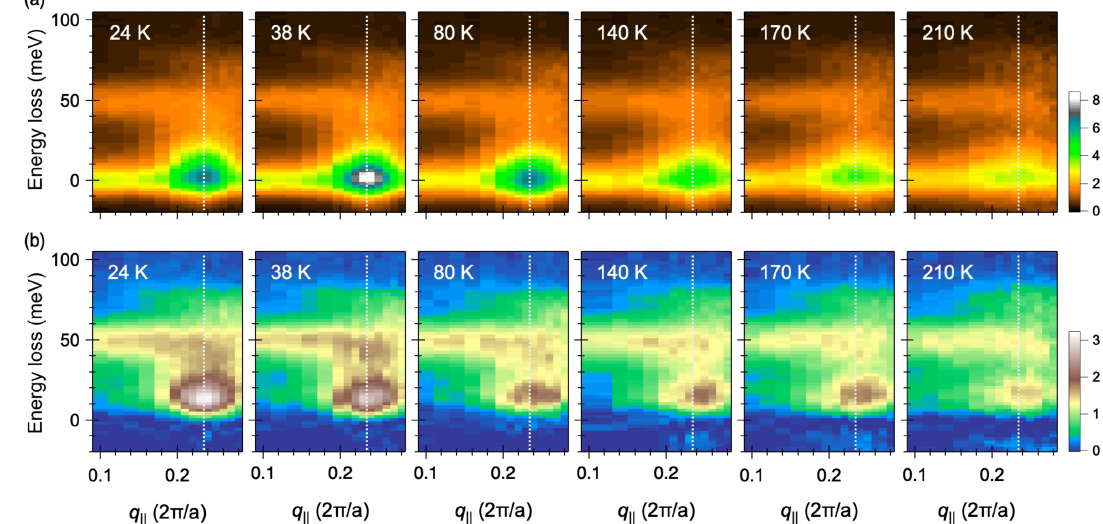
FIG. 2. Temperature-dependent O K -edge RIXS of optimally doped LSCO. (a) RIXS intensity distribution maps in the plane of energy loss vs in-plane momentum transfer q k along ð π ; 0 Þ at various temperatures. (b) RIXS intensity distribution maps after the subtraction of elastic scattering. All RIXS spectra are recorded with σ -polarized incident x rays of energy tuned to the ZRS hole. The momentum transfer is q ¼ ð q k ; 0 ; L Þ with L varying between 0.47 and 1.03 in reciprocal lattice units. Dotted lines indicate the position of measured ¼ ð 0 . 23 ; 0 ; L Þ q CDW